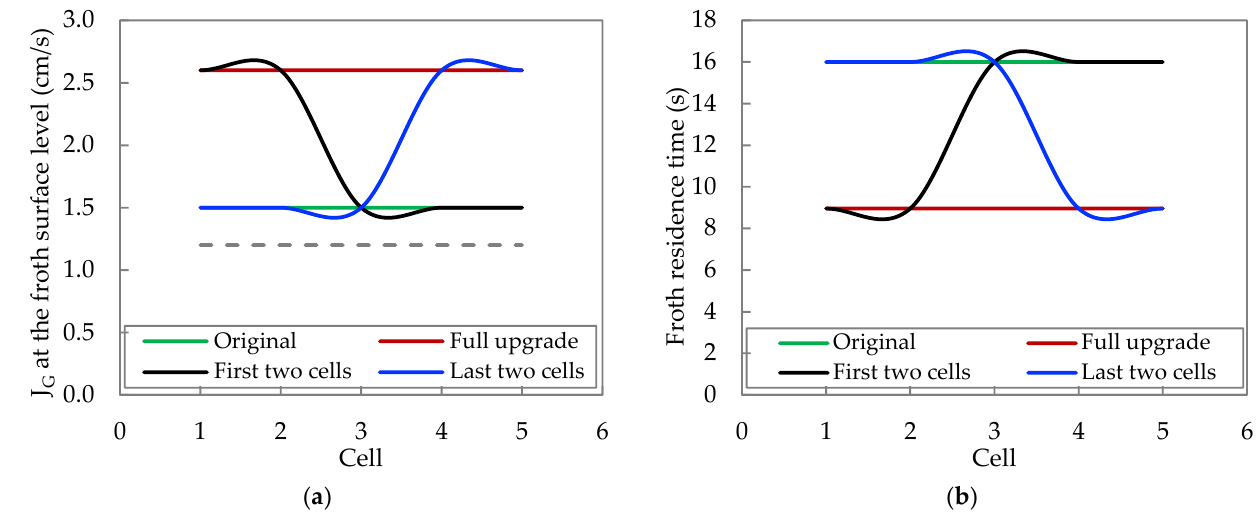
Figure 6. ( a ) J G profiles at the froth surface level and ( b ) Froth residence time profiles.